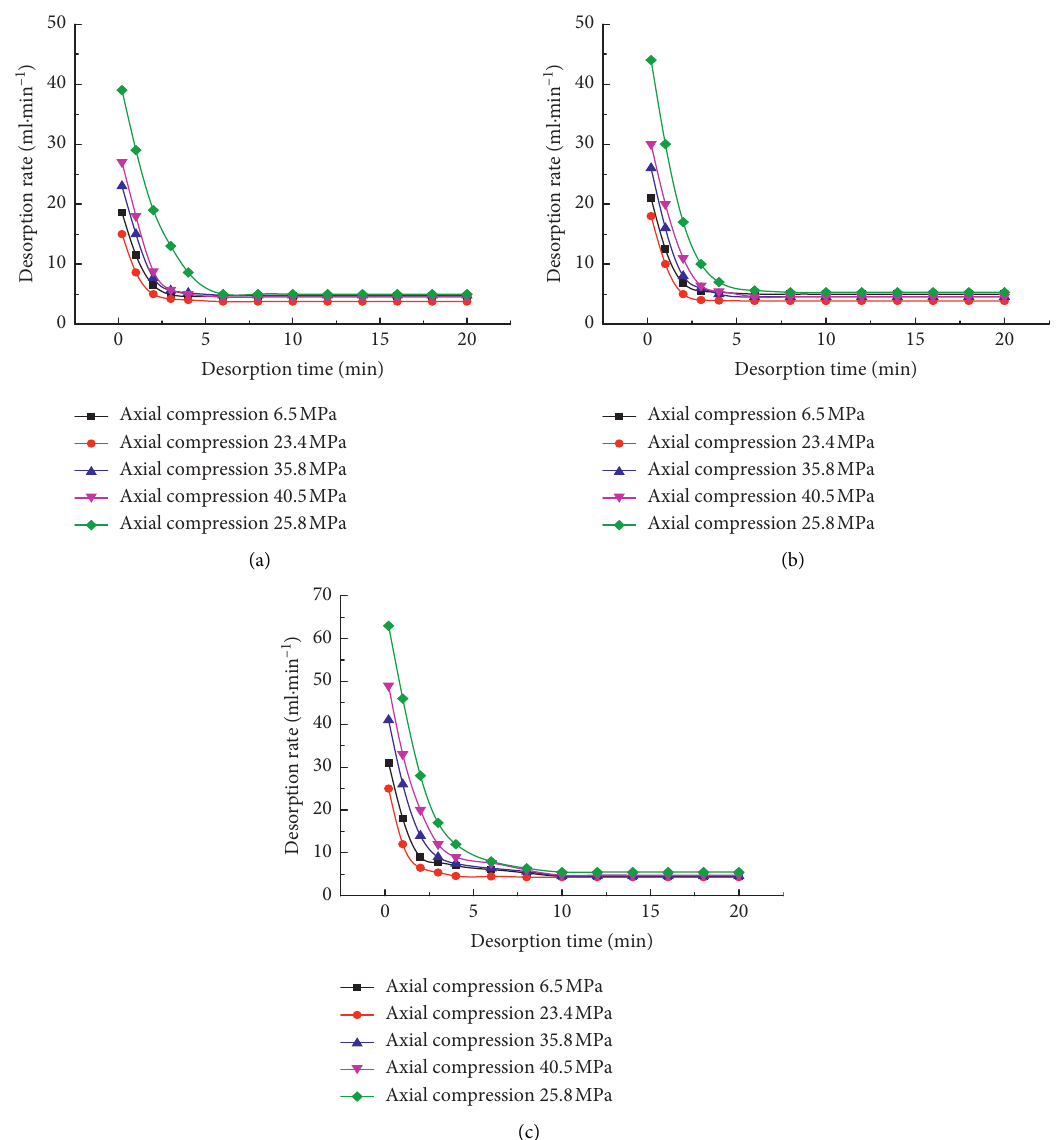
Figure 13: Desorption rate curve under the confining pressure of 3MPa at the temperature of (a) 30 ° C, (b) 45 ° C, and (c) 60 °